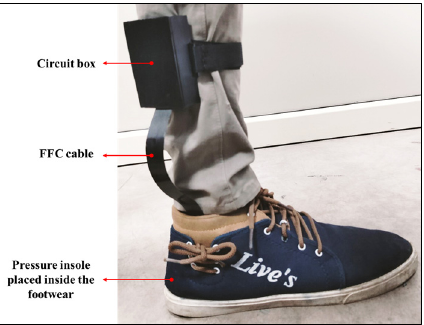
Figure 8. A volunteer wearing the developed pressure measurement device setup.